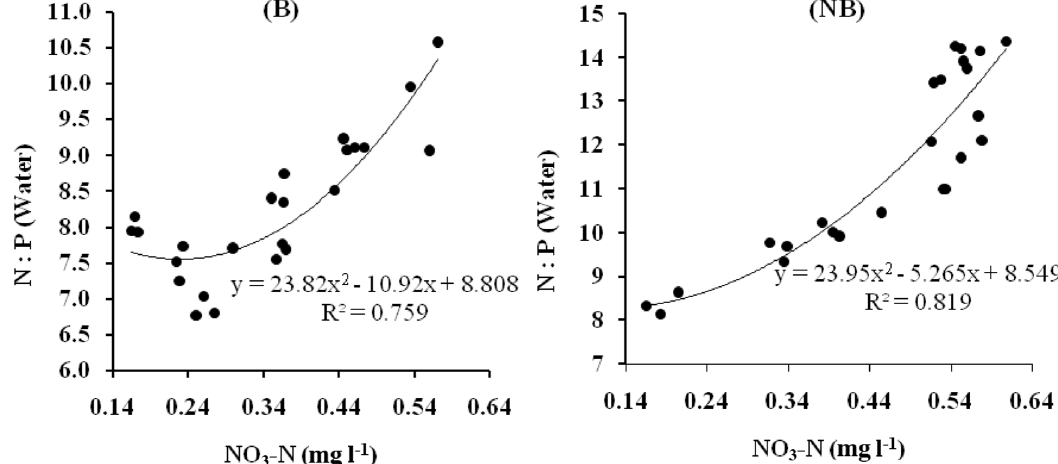
Fig. 5. Fitted relationship between NO 3 -N and N:P ratio in without neem (a) and neem based (b) bio fl oc